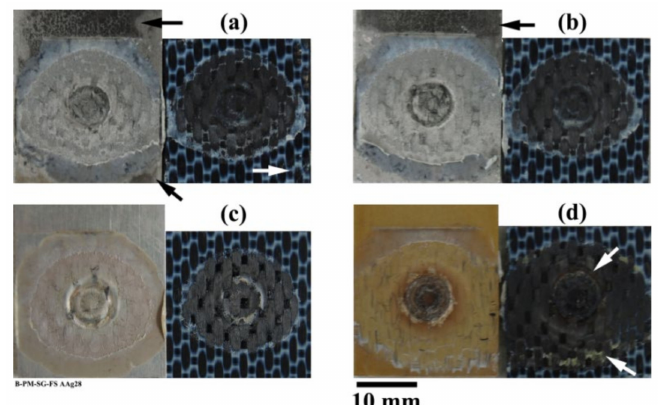
Figure 11. Fracture surface of the SLS joints after 28 days accelerated aging; ( a ) SB, ( b ) CC, ( c ) PAA, and ( d ) PAA-P. The black arrows in ( a ) and ( b ) indicate the aluminum hydroxide formation. The white arrow in ( a ) indicates small features outside the AZ. The white arrows in ( d ) indicate the primer remaining attached to the CF-PPS.